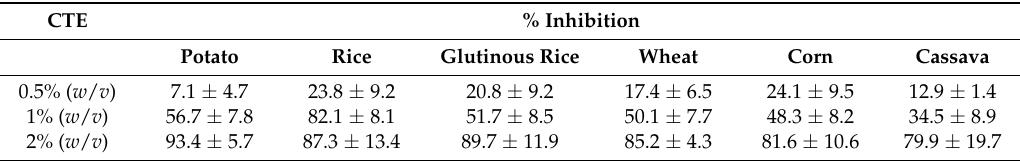
Table 1. The percentage of pancreatic α-amylase inhibitory activity of CTE. CTE % Inhibition